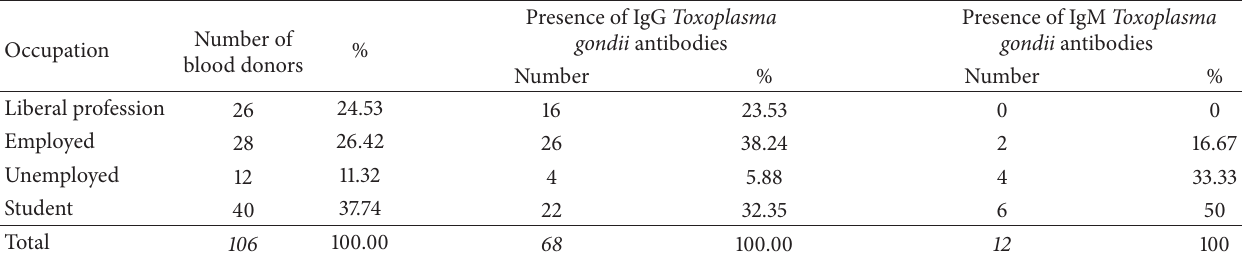
Table 4: Distribution of donors depending on the profession and the presence of IgM and IgG Toxoplasma gondii